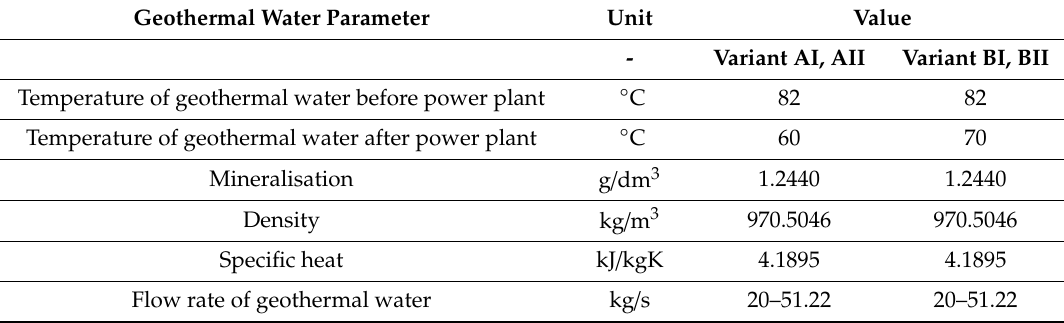
Table 1. List of parameters of the C-PIG-1 geothermal well included in the calculations. Geothermal Water Parameter